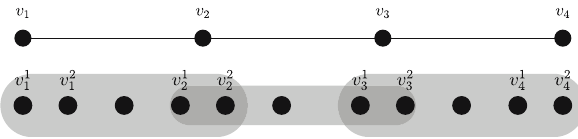
Figure 2: The power hypergraph P 4 25 ( )